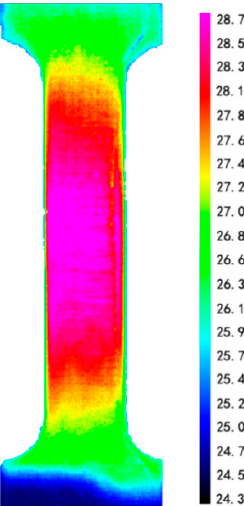
Figure 5. Installation diagram of the fatigue test and thermal measurement.